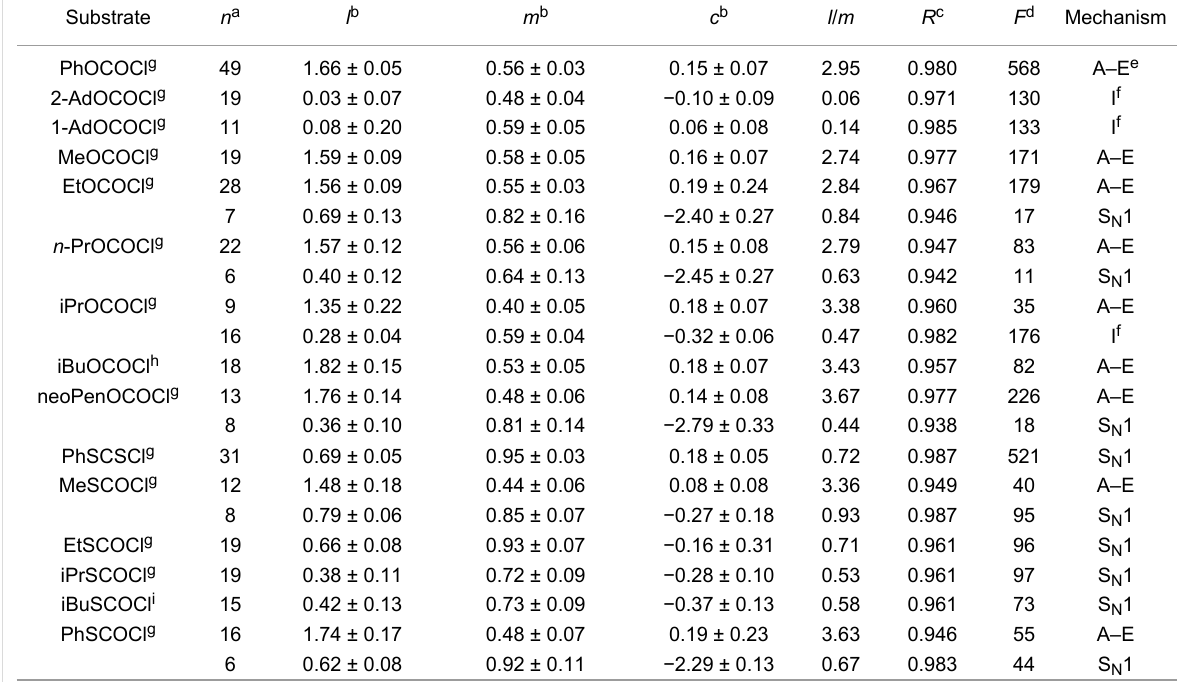
Table 3: Correlation of the specific rates of solvolysis of iBuOCOCl and iBuSCOCl (this study) and several other chloroformate and chlorothioformate esters (values from the literature), using the extended Grunwald–Winstein equation (Equation 1). Substrate